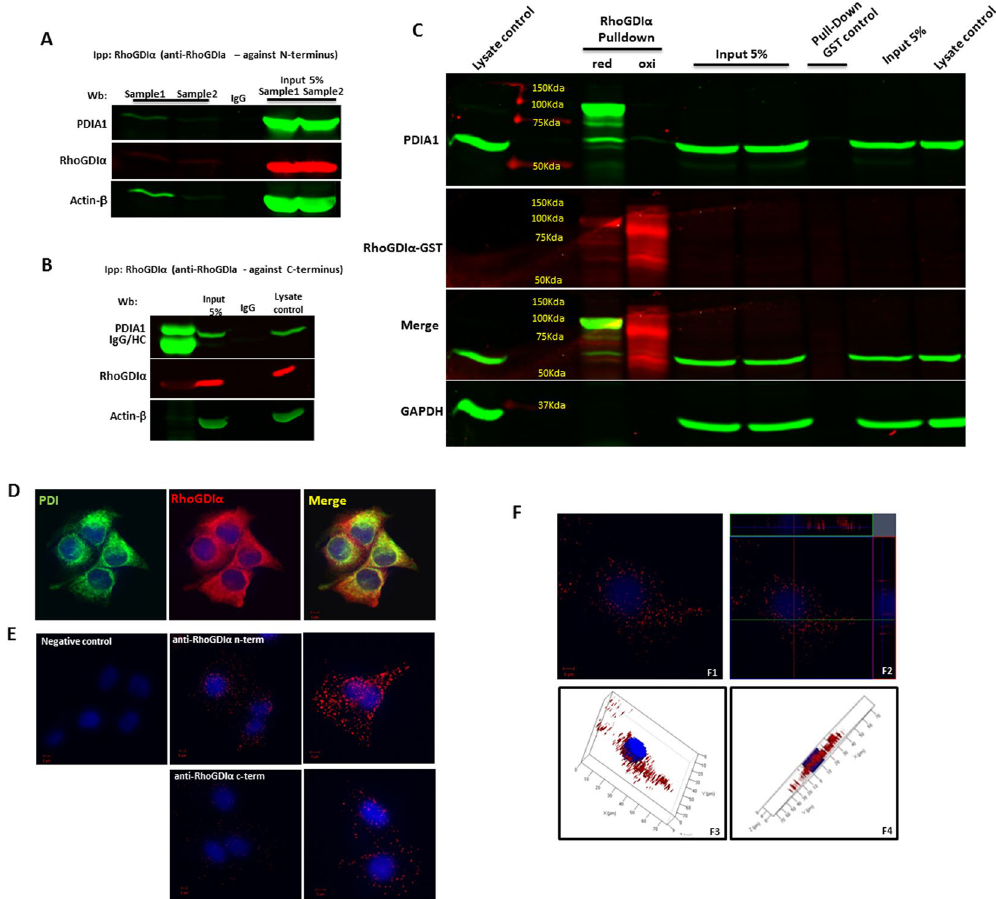
Figure 8. Physical interaction between PDIA1 and RhoGDI α in endothelial cells. ( A ) and ( B) RhoGDI α immunoprecipitation followed by Western blot for PDIA1. RhoGDI α was immunoprecipitated using IgG against N-terminus ( A ) or C-terminus ( B ). ( C) PDI and RhoGDI α interaction by pulldown assay. Using RhoGDI α -GST which was either reduced (DTT 20 mM) or oxidized (H2O2 20 mM), we pulled down PDI from HUVEC lysates under reduced conditions. Reduced RhoGDI α was able to pull-down PDIA1 as a monomer and as an apparent heterodimer, while oxidized RhoGDI α incubation resulted in the appearance of its dimeric form. Results representative from 3 experiments. ( D) Confocal microscopy images for PDIA1 and RhoGDI α showing co-localization. Representative results of three experiments which were replicated using 2 different antibodies to PDIA1 and 2 different antibodies to RhoGDI α (N-terminus and C-terminus). Magnification 40x and zoom 2.5x; Uncropped western blots are shown in Supplementary Fig. S10. ( E) Representative confocal images of proximity ligation assay (PLA) analysis showing the interaction between PDI and RhoGDIA α in HUVEC. Positive signal of protein interaction is represented as a red dot; nuclei are stained with DAPI (blue). Cells in panels E1-E4 were incubated with a mix of antibodies against PDIA1 and RhoGDI α . Panel B shows negative control in which the primary antibodies were omitted. Magnification: in E, 40x; in F1/F3, 40x and zoom 2x; in F2/F4, 63x and zoom 2x; ( F) Representative ortho-images (F1 and F2) and 3D reconstruction (F3 and F4) of confocal z-stacks of PLA showing PDI/RhoGDI α dimer distribution into HUVEC. The center image of each panel (shown by crossing lines) is the X-Y view, cross section at the green line is X-Z view and cross section at red line is Y-Z